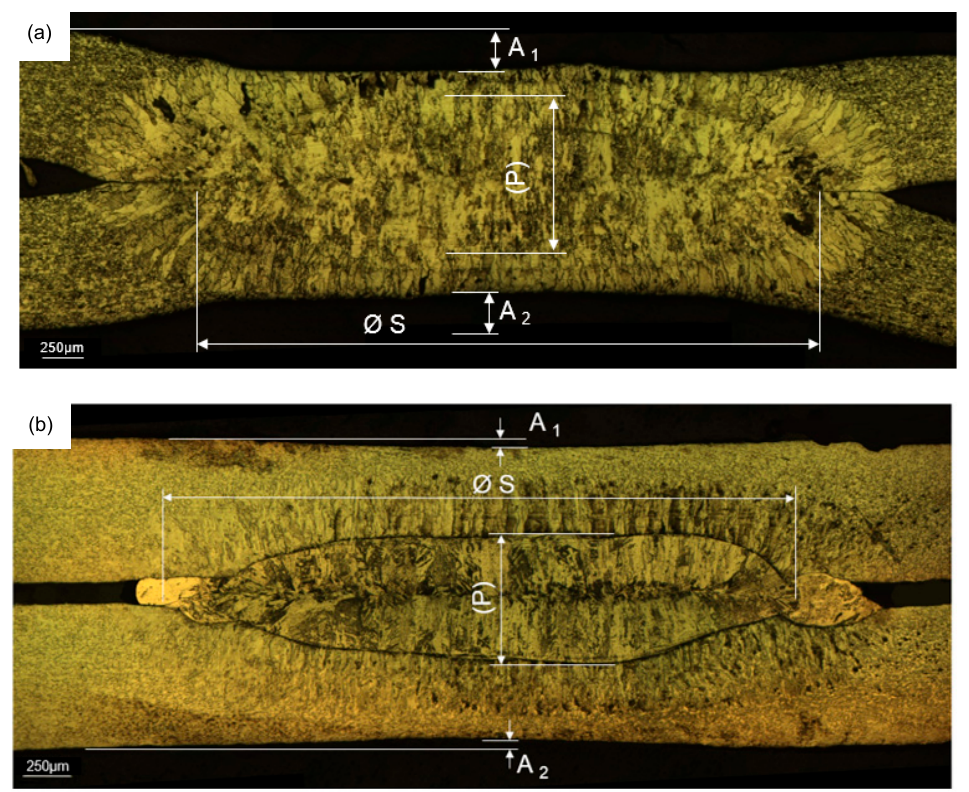
Figure 1. ( a ) Macrography related to the conventional resistance spot welding process (RSW). ( b ) Macrography related to the process of spot welding using additive manufacturing (AMSW) [12]. Although this new welding process (AMSW) is similar to projection welding, it has completely different characteristics regarding mechanical and metallurgical properties. For example: AMSW welding has no sheet thickness limit; the height of the projection is unique for any thickness (0.3 ±